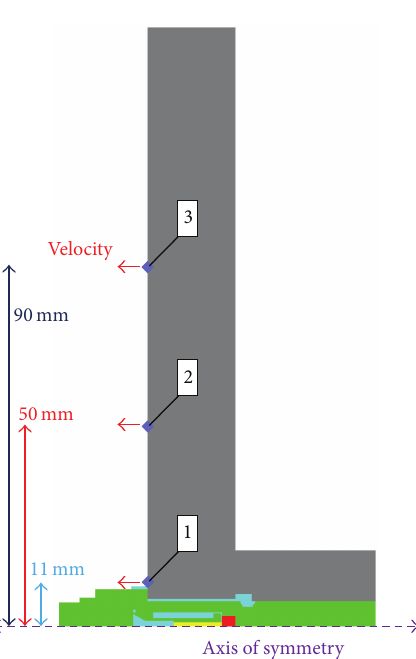
Figure 10: Position of gauges for pyroshock prediction.